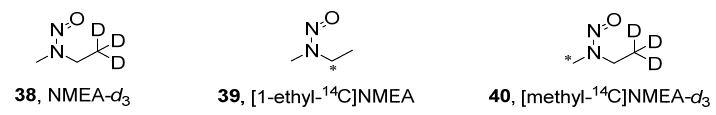
Figure 4. Structures of isotope-labeled NMEAs.